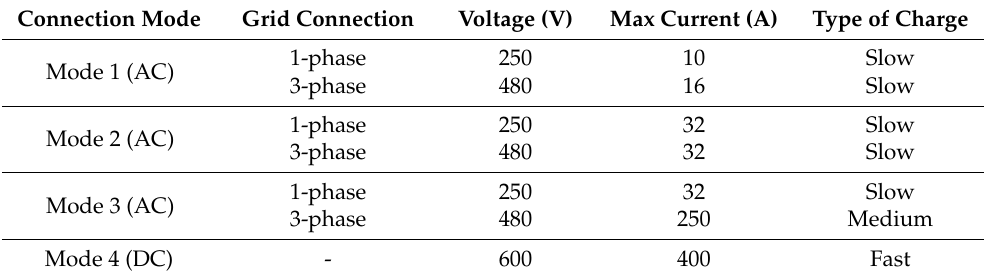
Table 3. Different Charging Modes.